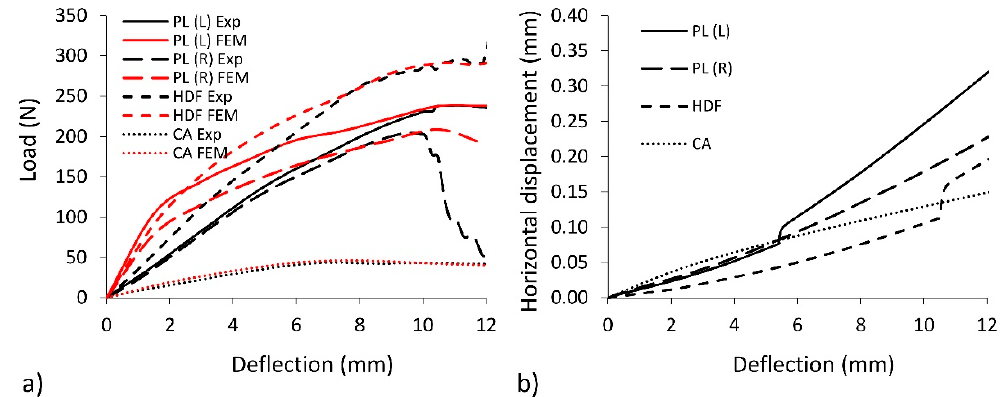
Figure 10. Stiffness characteristics of multilayer beams and ( a ) value of numerical calculations of crack displacement during bending ( b ).